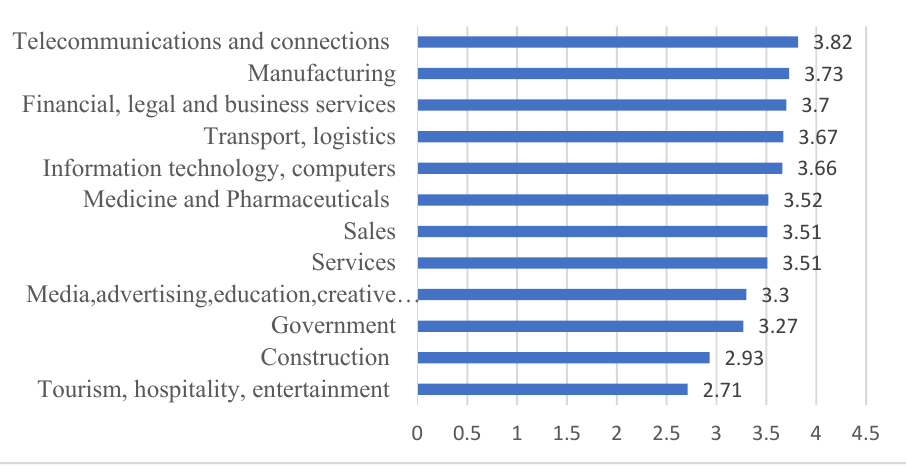
Figure 4. Average attitude towards AI according to industry.